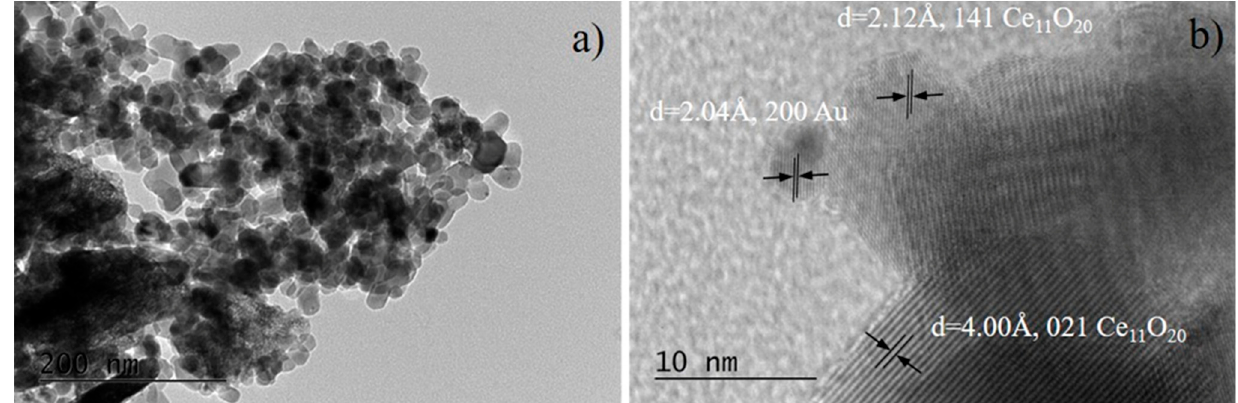
Figure 3. TEM image at magnification 40,000× ( a ) and HRTEM image at magnification 600,000× ( b ) for Au/Co-Ce sample.